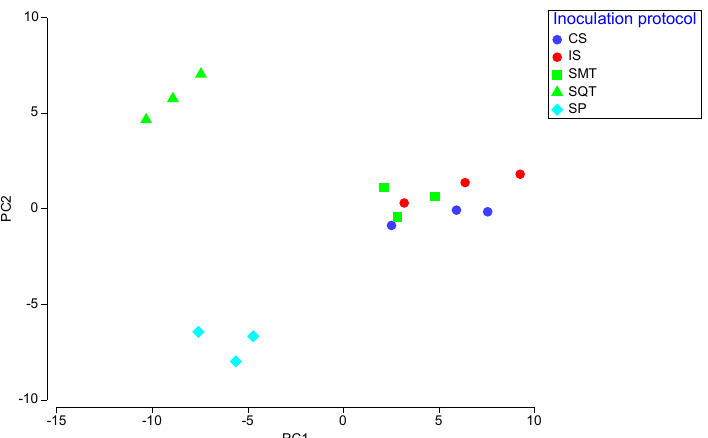
Figure 4. Principal Component Analysis (PCA) of the chemical characteristics wines produced in microvinifications. CS: commercial S. cerevisiae ; IS: S. cerevisiae ScS13; SMT: T. delbrueckii TdS6 and S. cerevisiae ScS13 added simultaneously; SQT: T. delbrueckii TdS6 and S. cerevisiae ScS13 added sequentially.